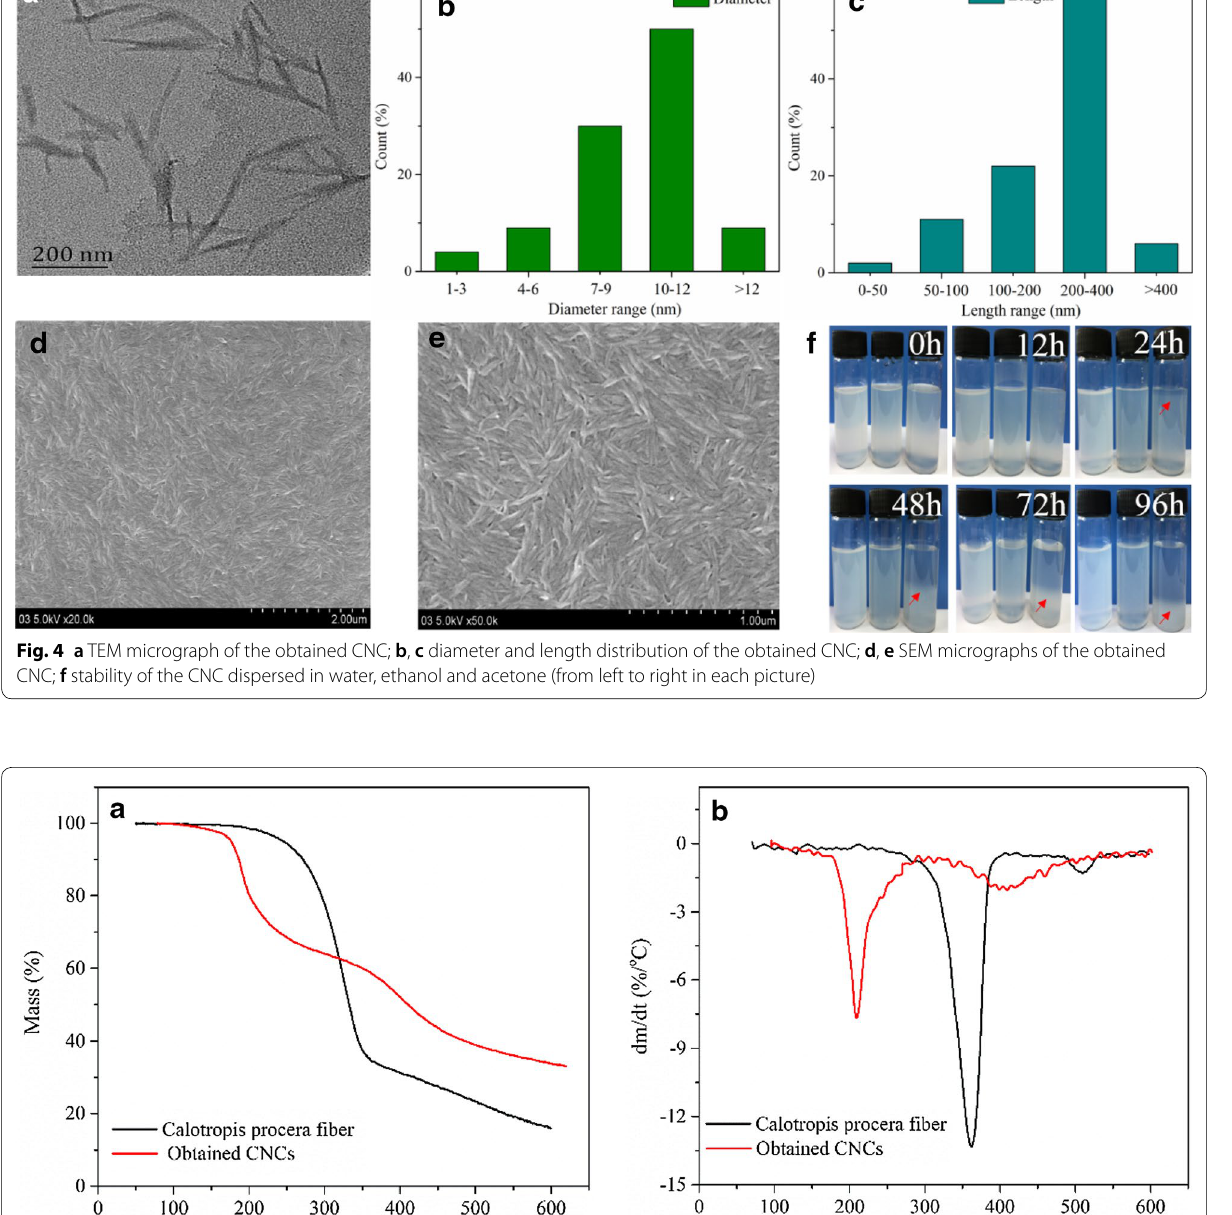
The FTIR spectra of the original Calotropis procera